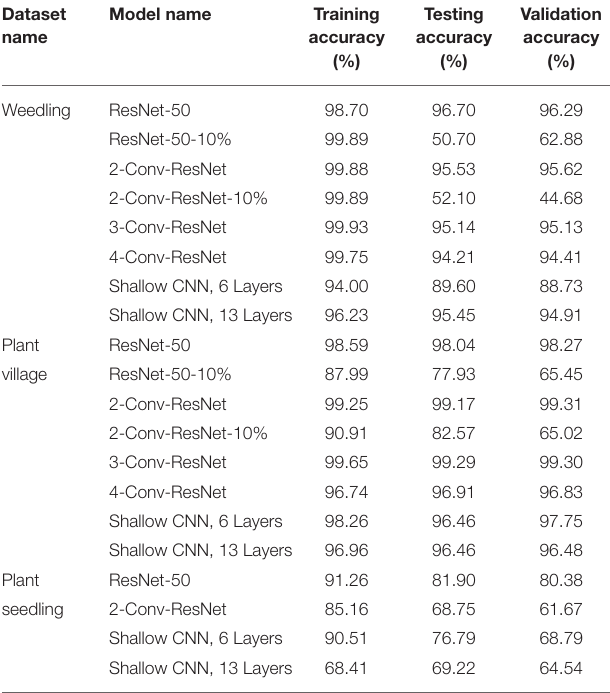
TABLE 1 | Performances of different models for various